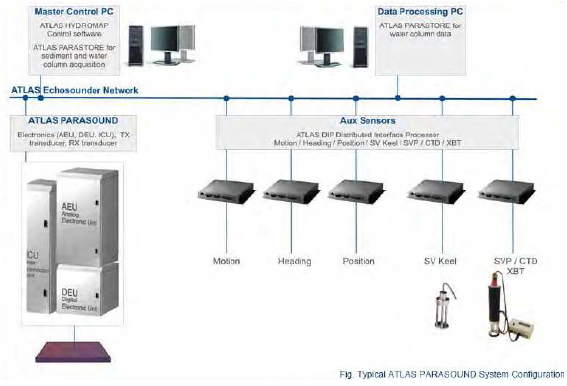
Figure 12. Parasound P – 35 Seismic system and subsystems